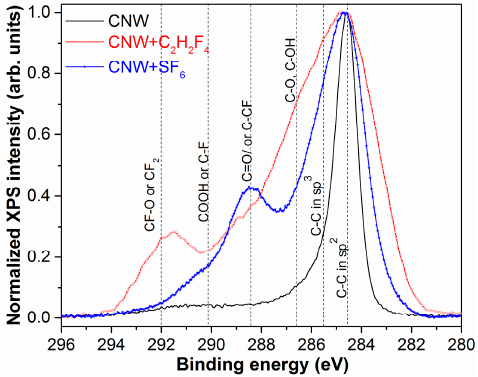
Figure 6. Normalized high-resolution spectra of CNW and treated CNW by SF 6 and C 2 H 2 F 4 plasma.